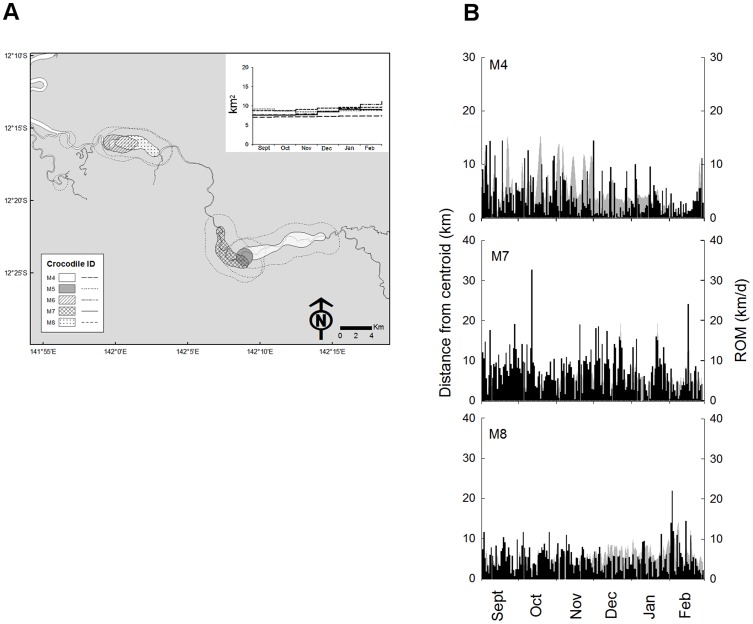
Movement patterns of 'site-fidelic' male Crocodylus porosus.(a) KUD 50% and KUD 95% (dotted boundary) calculated from GPS-location fixes recorded between 01 September and 28 February (n = 5). Inset graph shows the monthly cumulative KUD 95% for each individual. (b) The relationship between daily rate of movement (ROM) and daily distance from the KUD 50% centroid (grey = primary y-axis; black = secondary y-axis).